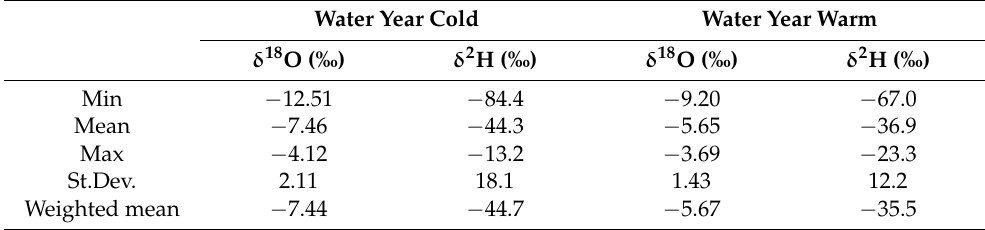
Table 4. Statistical data on the content of stable isotopes in precipitation collected at the Kukuljanovo rain gauge station in 2008–2012. The weighted mean was calculated using the amount of precipitation as a scale. Water Year Cold represents October to March period, and Water Year Warm period